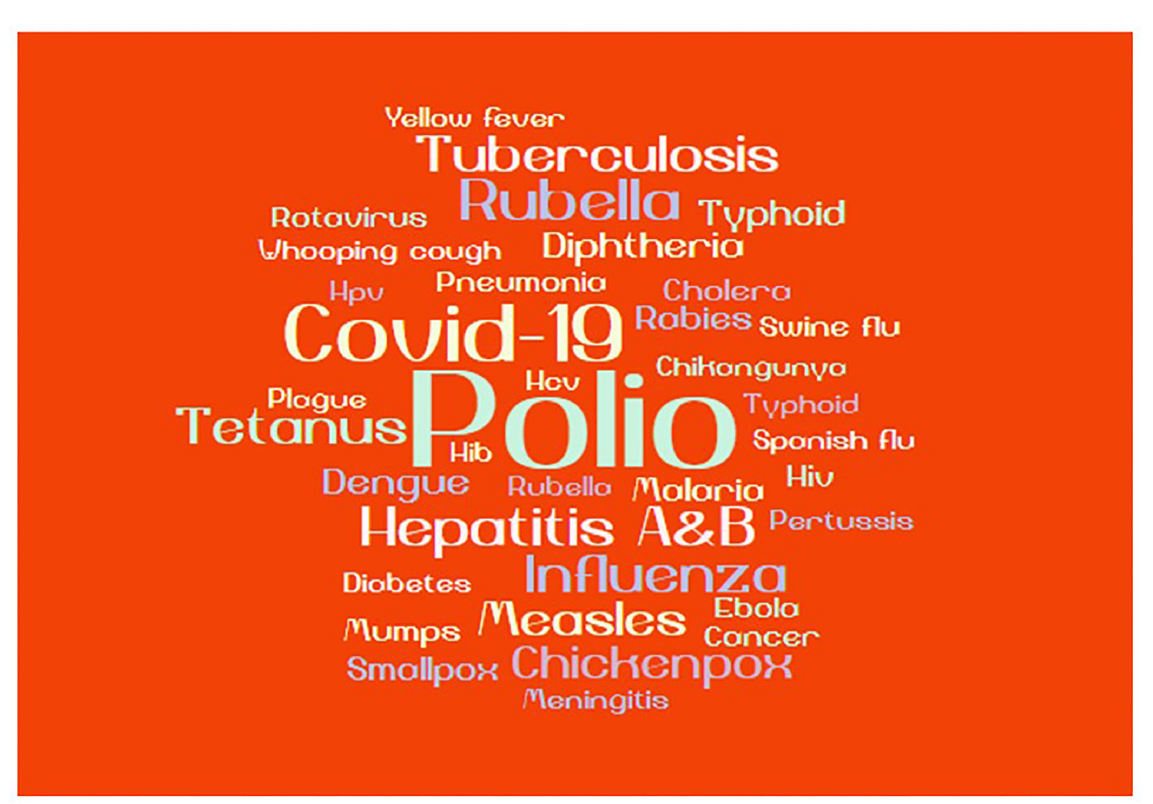
FIGURE4 Knowledge of vaccines. The word cloud demonstrates the frequency of people who responded to the mentioned diseases against which they knew how vaccines were approved. In the word cloud, the size of each disease (word) is proportional to its